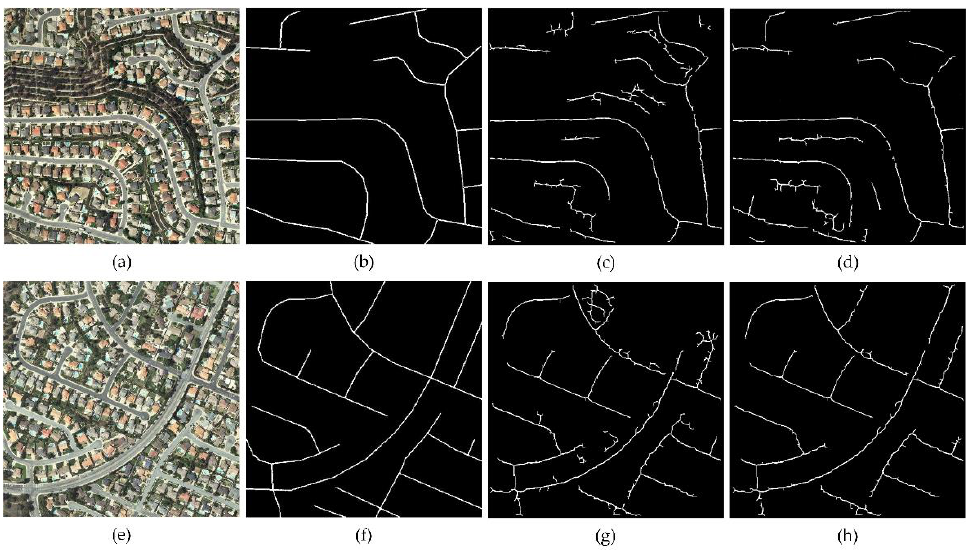
Figure 12. Comparison of the method of Lei et al. [26] and the proposed method in an urban area; ( a , e ) original image; ( b , f ) road-vector data from manual acquisition; ( c , g ) results of the method of Lei et al.; ( d , h ) results of proposed method.